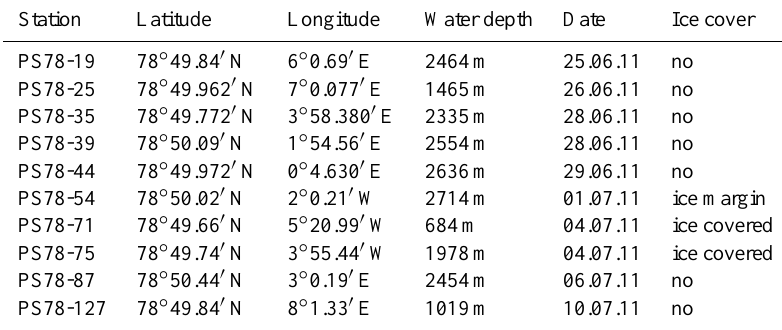
Table 1. List of the stations sampled during cruise ARK-XXVI/1 in June/July 2011. Station Latitude Longitude Water depth Date Ice cover